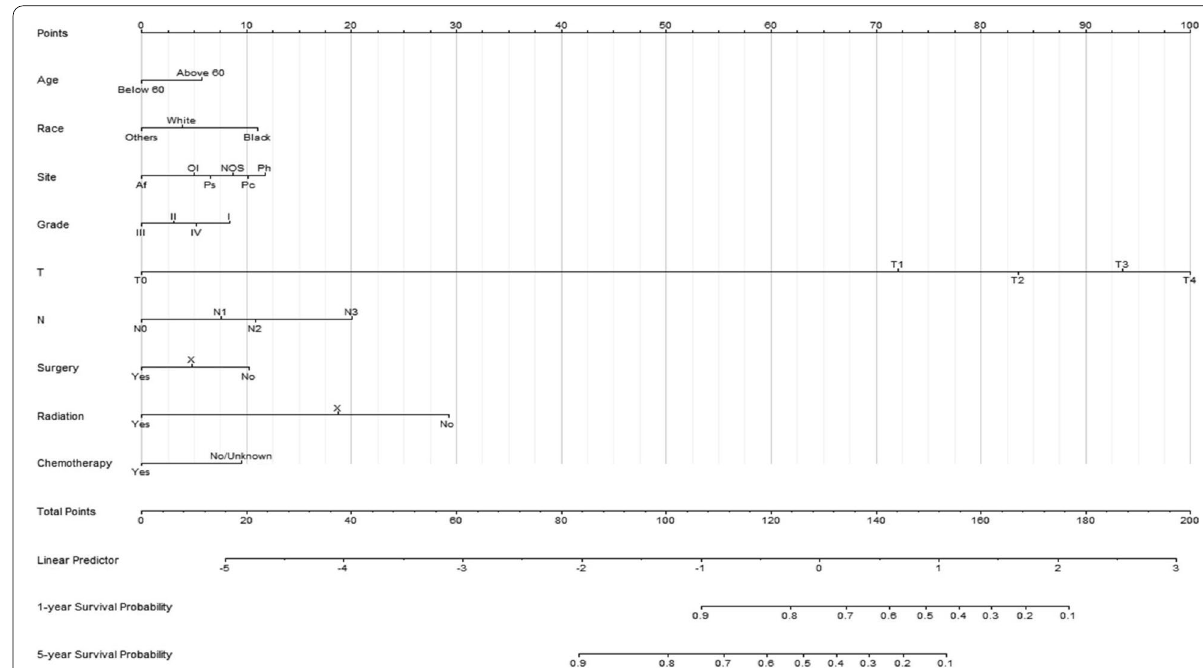
Fig. 3 Clinical nomogram of the training group for non-metastatic HC patient stages. Abbreviations: Ps, pyriform sinus; Pc, post-cricoid; Af, aryepiglottic fold; Ph, posterior wall of hypopharynx; Ol, overlapping lesions; NOS, not otherwise